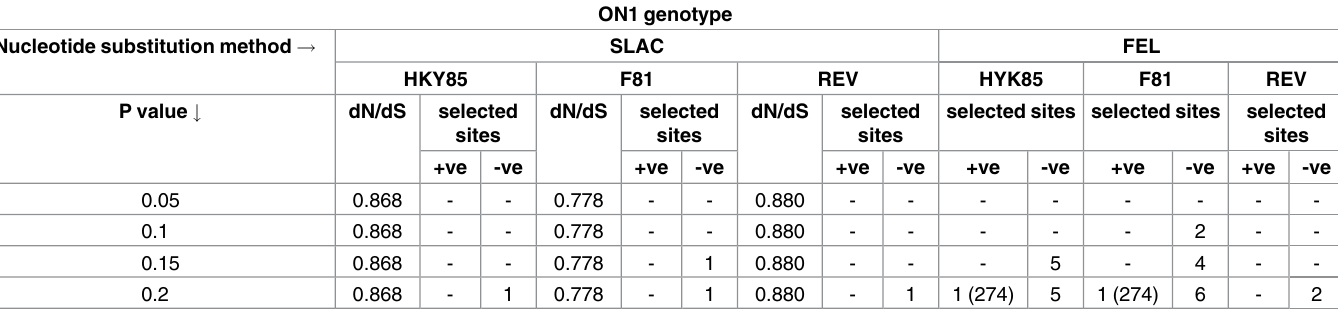
Table 4. Selection pressure analysis of the RSV ON1 genotype of the second hypervariable region of G protein gene using SLAC and FEL method. ON1 genotype